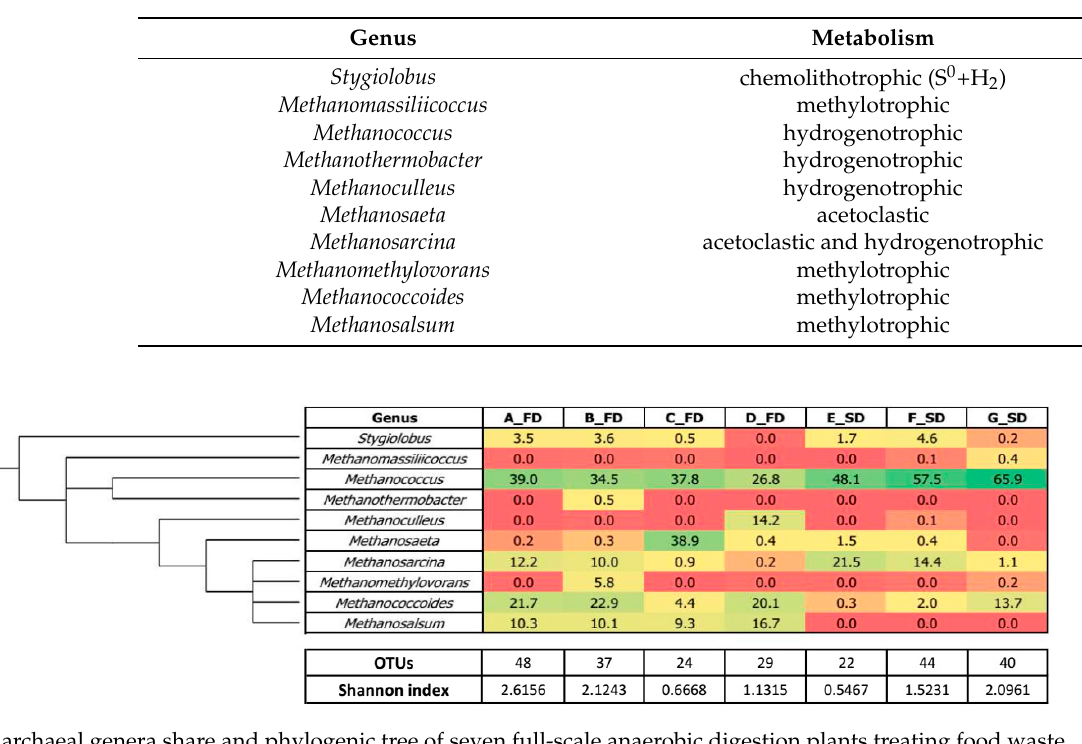
Table 2. Metabolic association of archaea observed in seven full-scale anaerobic digestion plants treating food waste and sewage sludge (genus level according to Figure 2).